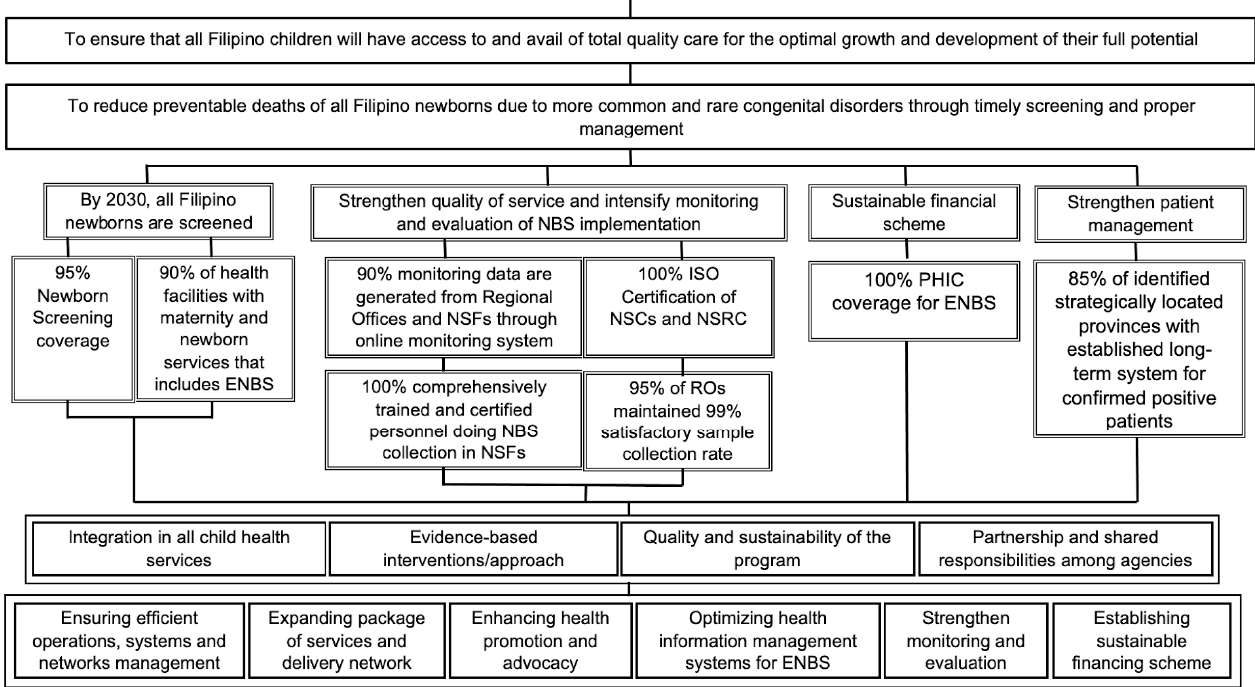
Figure 3. Planning diagram (2017—2030) for expanded newborn screening (adapted from reference [48]). Abbreviations used: NBS = Newborn Bloodspot Screening; ENBS = Expanded Newborn Bloodspot Screening; ISO = International Organization for Standardization; NSC = Newborn Screening Center; NSF = Newborn Screening Facility; PHIC = Philippine Health Insurance Corporation; RO = Regional Office.